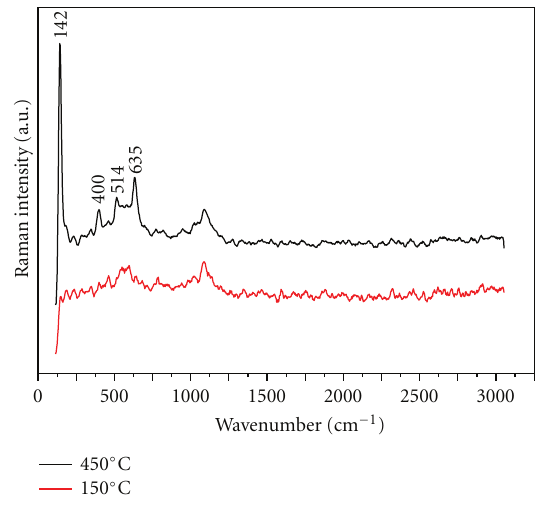
Figure 3: Raman spectra of titanium dioxide deposited on glass/FTO substrate at 150 ◦ C (amorphous phase) and 450 ◦ C (ana- tase phase). The peak at 1090 cm − 1 (not indicated) identifies the substrate.